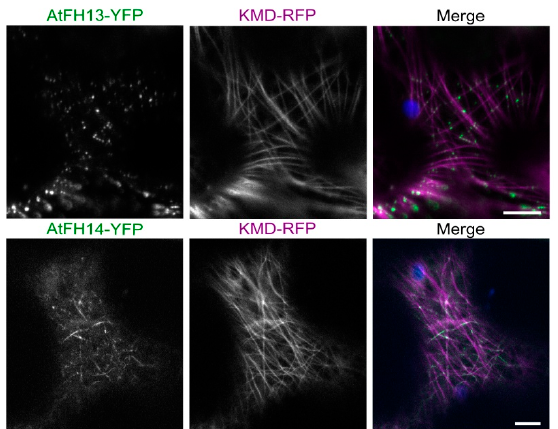
Figure 4. Single optical sections of epidermal cells co-expressing AtFH13-YFP or AtFH14-YFP with the microtubule marker KMD-RFP. Images from single channels are shown in grayscale, merged images display an overlay of three channels represented by green (YFP), magenta (RFP), and blue (chloroplast autofluorescence). Scale bar is 10 µm. Construct abbreviations are defined in the text and in Figure 1. To confirm functional connection between the AtFH13-labelled foci and the microtubule cytoskeleton, we examined the e ff ect of the microtubule depolymerizing drug oryzalin on localization of AtFH13-YFP co-expressed with KMD-RFP. The oryzalin treatment caused partial redistribution of the cytoplasmic dots and increased their mobility, which may be due to cytoplasmic streaming, not a ff ected by microtubule disruption (Figure 5). This suggests that integrity of microtubules is essential to maintain subcellular distribution of AtFH13.